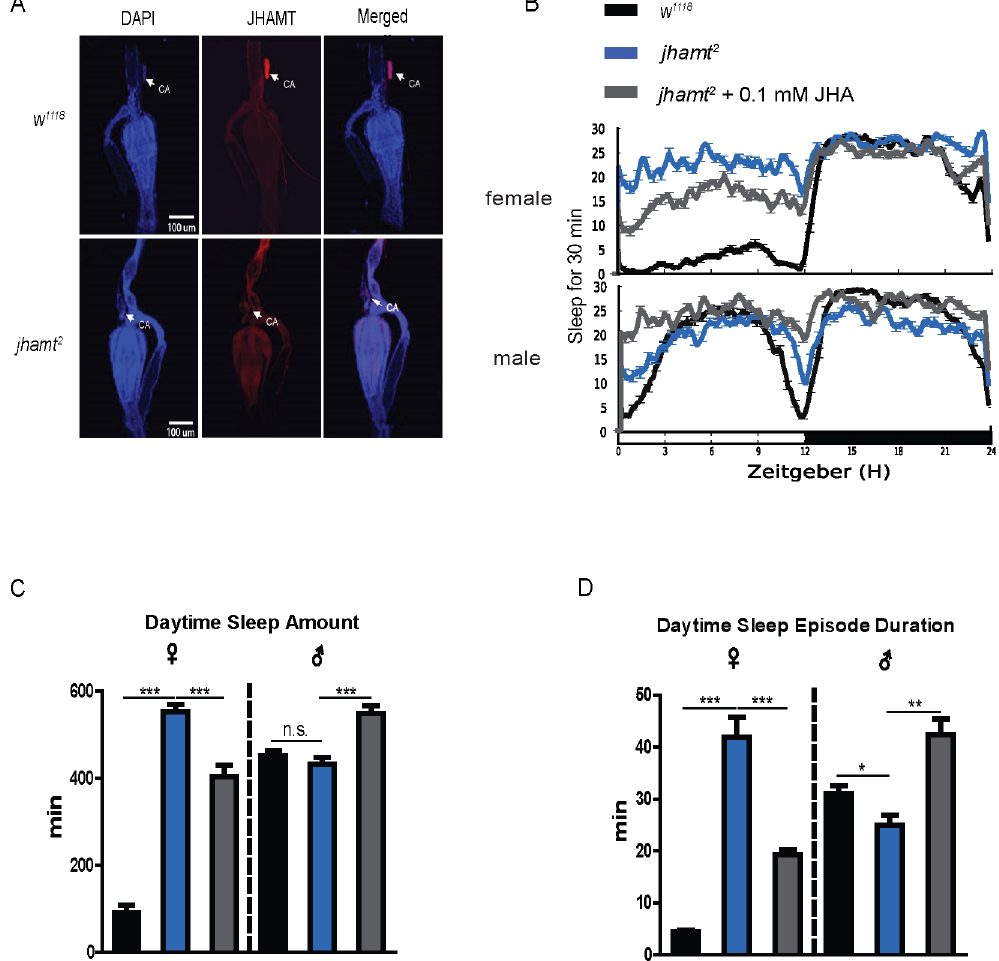
Fig 2. Effects of jhamt mutation on sleep behaviors. (A) JHAMT protein could not be detected in jhamt 2 corpora allata cells. The blue represents DAPI, the red represents anti-JHAMT, and the third column represents a co-location of DAPI and anti-JHAMT. (B) Sleep trace graph of jhamt 2 and JH analog-fed jhamt 2 flies. The dark, blue and gray lines represent w 1118 , jhamt 2 and 0.1mM JH analog-fed jhamt 2 flies, respectively. (C) Daytime sleep amount of jhamt 2 and JH analog-fed jhamt 2 flies. With loss of jhamt function, daytime sleep amount in the female significantly increased, and the males had a slight but not significant decrease in daytime sleep amount. The effects of administration of JH analog were consistent with Fig 1D. Data represent mean±SEM (n = 32–96). n.s. represents no significant difference, (cid:3)(cid:3)(cid:3) P < 0.001 determined by Student’s t test. (D) Daytime sleep-bout duration of jhamt 2 and JH analog-fed jhamt 2 flies. The results were generally consistent with their daytime sleep, except that the sleep-bout duration of the male exhibited a significant difference between w 1118 and jhamt 2 . Data represent mean±SEM (n = 32–96). (cid:3) P < 0.05, (cid:3)(cid:3) P < 0.01, (cid:3)(cid:3)(cid:3) P < 0.001 determined by Student’s t